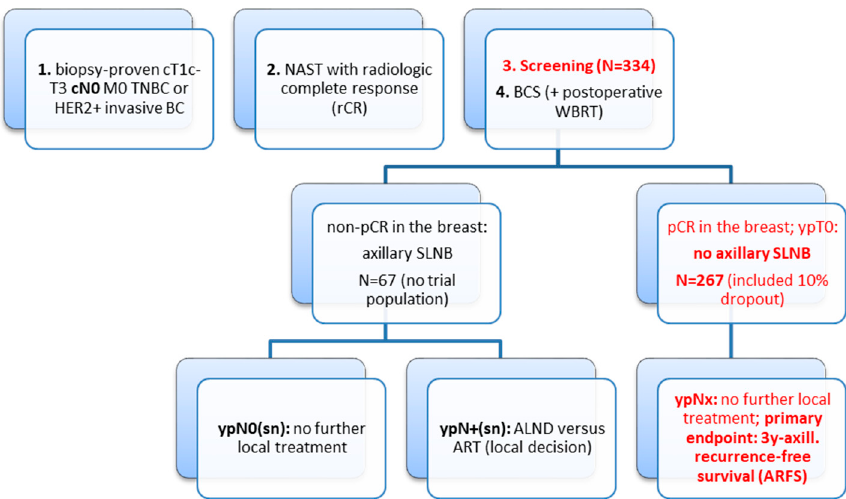
Figure 1. Flow chart of the EUBREAST-01 (GBG104) trial according protocol amendment #1. Assuming a 10% dropout rate for per-protocol analysis the required sample size for experimental single-arm is n = 267 (which is the expected 80% proportion of the screening population). TNBC: triple-negative breast cancer (ER-/PgR-/HER2-); BC: breast cancer; NAST: neoadjuvant systemic therapy; BCS: breast-conserving surgery; WBRT: whole-breast radiotherapy; SLNB: sentinel lymph node biopsy; pCR: pathologic complete response; cALND: completion axillary lymph node dissection; ART: axillary radiotherapy.